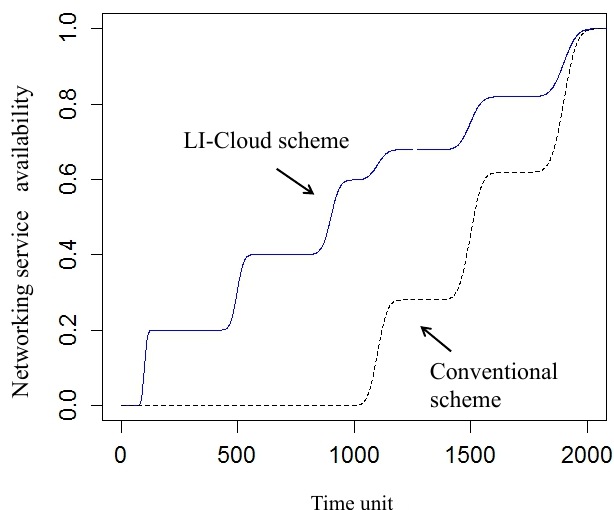
Figure 7. I-NSA for users in the scenario of sequential deployment of networking services with (Possion distribution of restoration. Ta, Tb, and Tc are set to 100, 500, and 900, and T AG , T BG , and T CG are set to 1100, 1500, and 1900,